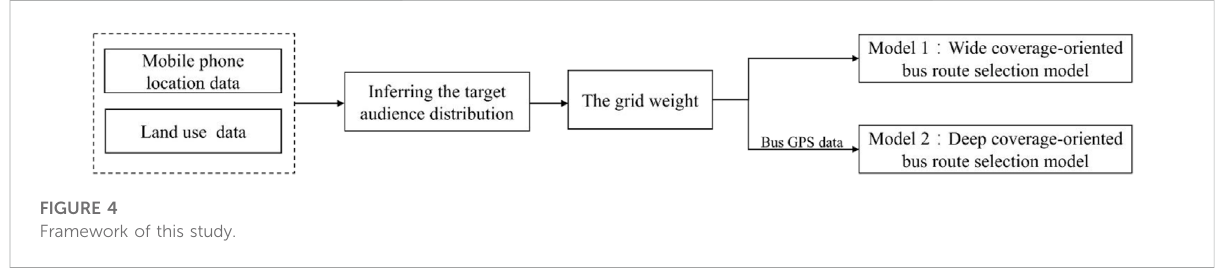
FIGURE 4 Framework of this